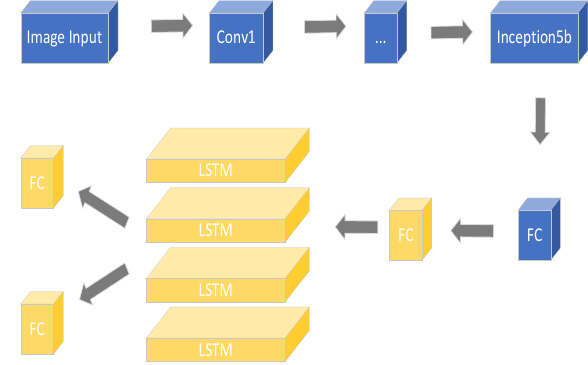
Figure 5 . Our image positioning